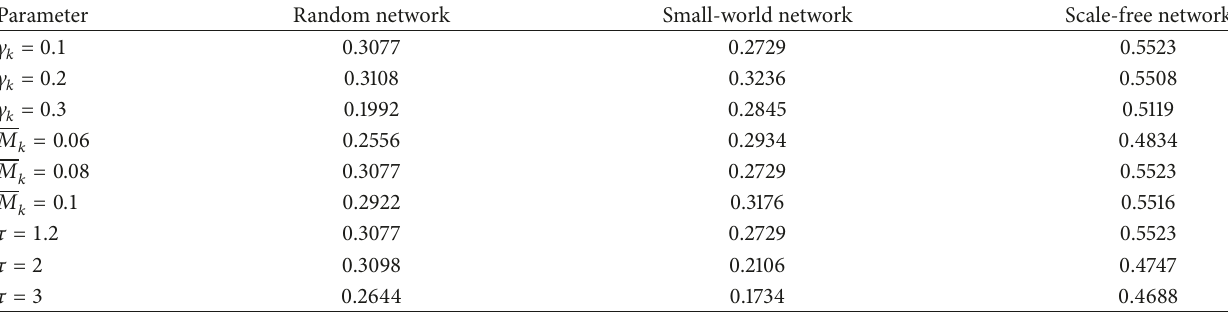
Figure 1: Network entropies and effects of systemic risk. (a), (b), and (c) correspond, respectively, to the results of random, small-world, and scale-free networks. Table 2: Pearson’s correlation coefficients between network entropies and systemic risk.